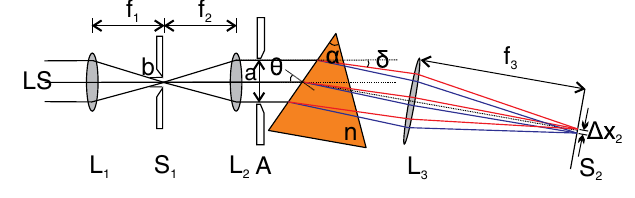
FIG. 3. Schematic of a prism spectrometer.